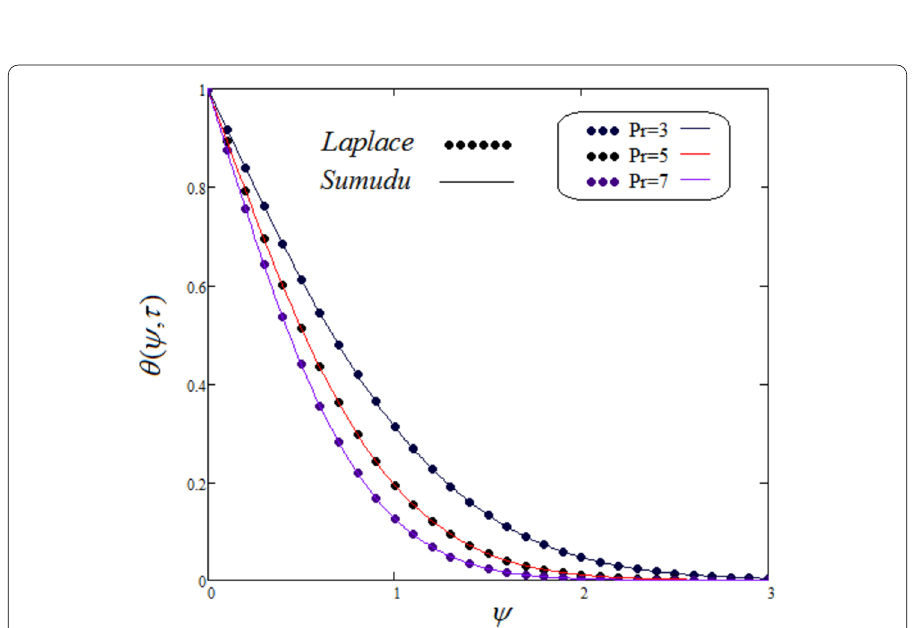
Figure 1 Temperature profile for different values of Pr via Laplace and Sumudu